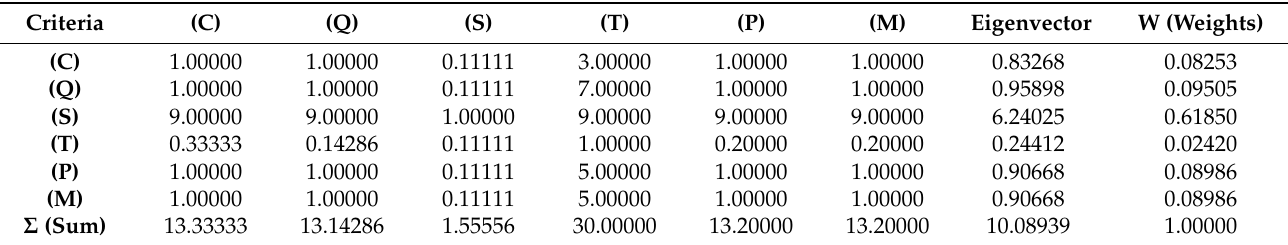
Table 11. Judgment matrix (full packaging engineer D).